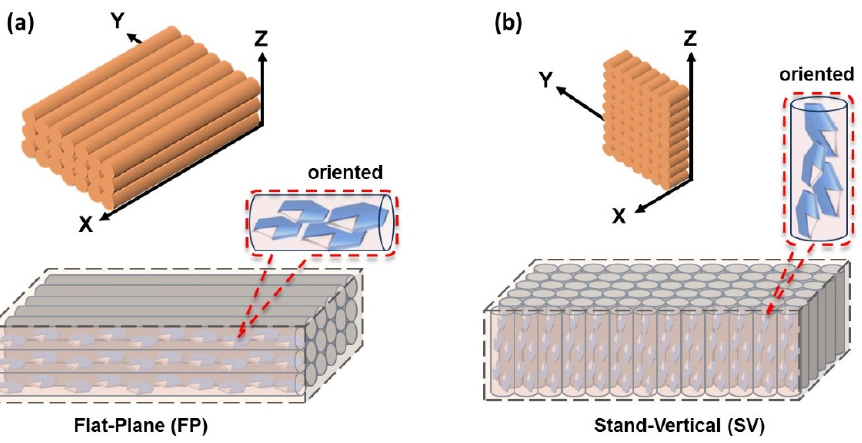
Figure 2. Schematics of the orientation of the OH-BN/ h -BN particle networks in the composite filaments prepared by two printing methods: ( a ) flat-plane, and ( b ) stand-vertical.